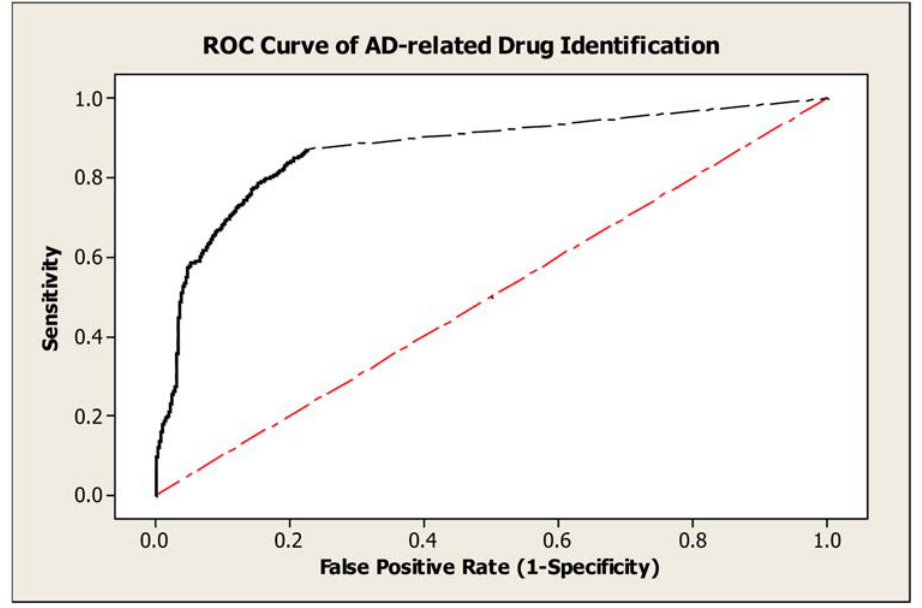
Figure 4. Specificity and sensitivity tradeoffs for AD-related drug identification. The ROC (receiver operating characteristic) curve shows the sensitivity vs. false positive rate (1-specificity) for AD-related drug identification, when FDR (false discovery rate) varies at different threshold levels. Evaluation results are built by querying against PubMed abstracts and Enrez gene function description in search of evidence that may contain any of the drug terms and the term ‘‘Alzheimer’s Disease’’ with all their term variants. The sensitivity and specificity are defined in Methods